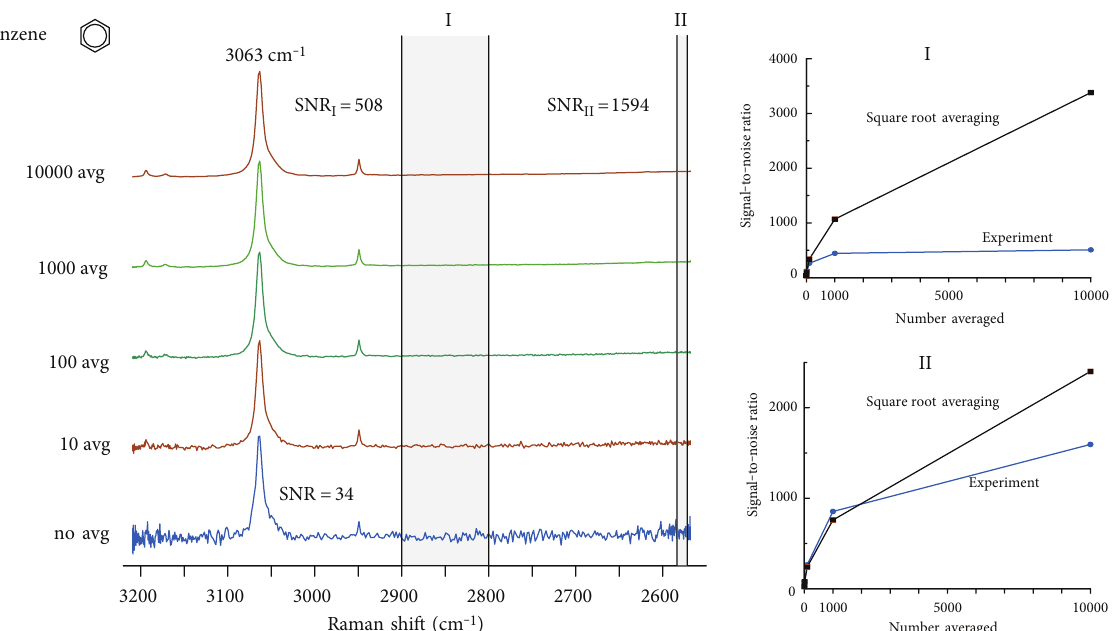
Figure 4: The result of averaging on the TICO-Raman spectrum of benzene. The lower, blue spectrum is the nonaveraged spectrum. The signal (3060cm − 1 peak) is 34 times higher than the standard deviation of the areas in I or II. Averaging leads to much increased Raman spectra and new spectral features become visible. The di ff erent spectra were vertically o ff set for clarity. The increase in signal-to-noise ratio (SNR) over the amount of averaging is plotted on the right, where two di ff erent regions of the spectrum were used to calculate the noise. Region I shows a higher standard deviation due to the contribution of an additional e ff ect — we assume cross-phase modulation (XPM, see text). In region II, this e ff ect is constant and does not enter the standard deviation, leading to an almost optimal square root increase in